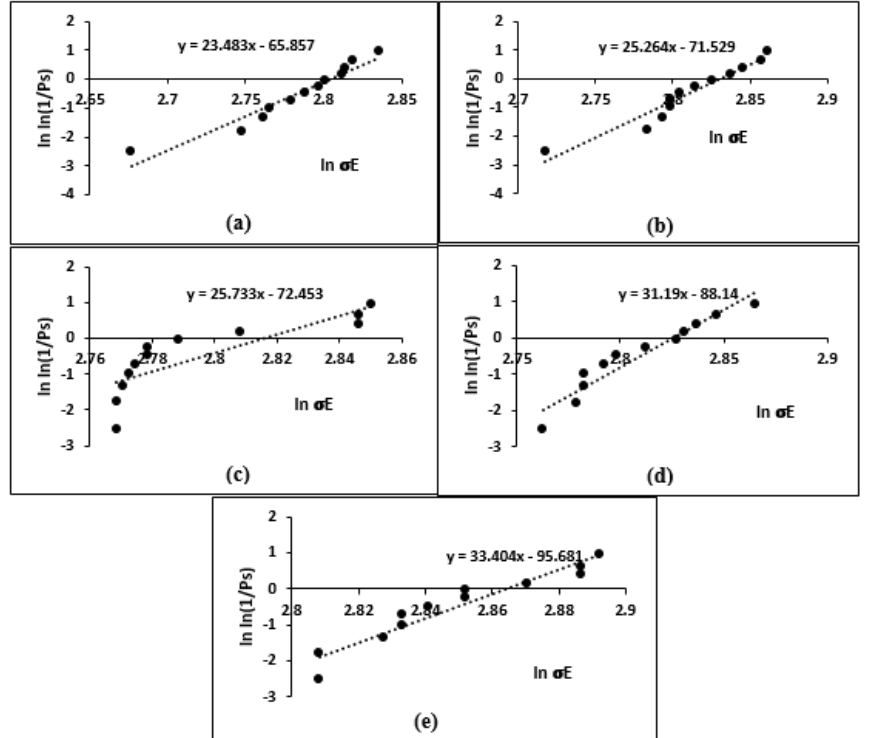
Figure 5: Weibull distribution of dielectric strength at various RRV: (a) 0.5, (b) 1, (c) 2, (d) 3 and (e) 5 kV/s, for 3 wt% Al 2 O 3 .